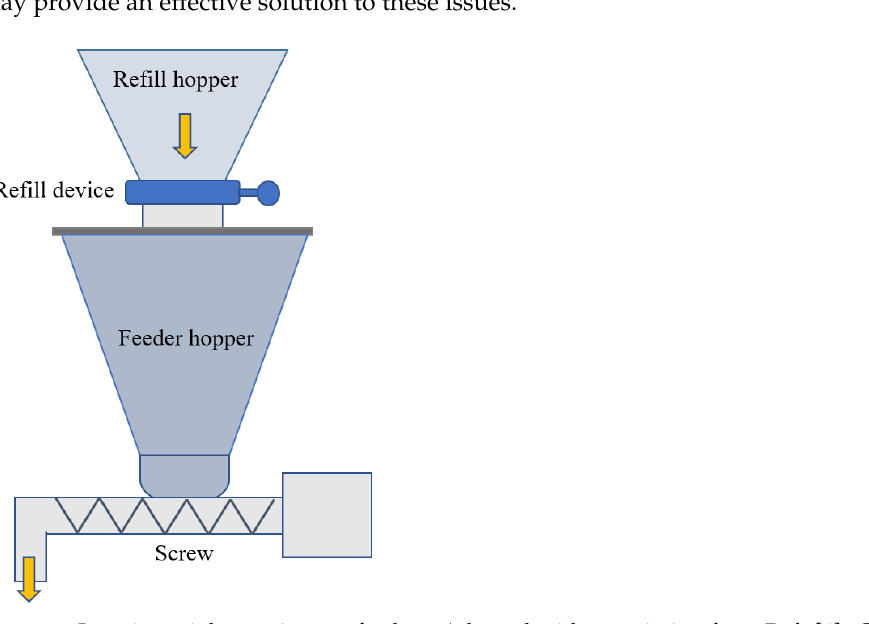
Figure 1. Loss-in-weight continuous feeder . Adapted with permission from Ref. [4]. Copyright 2015